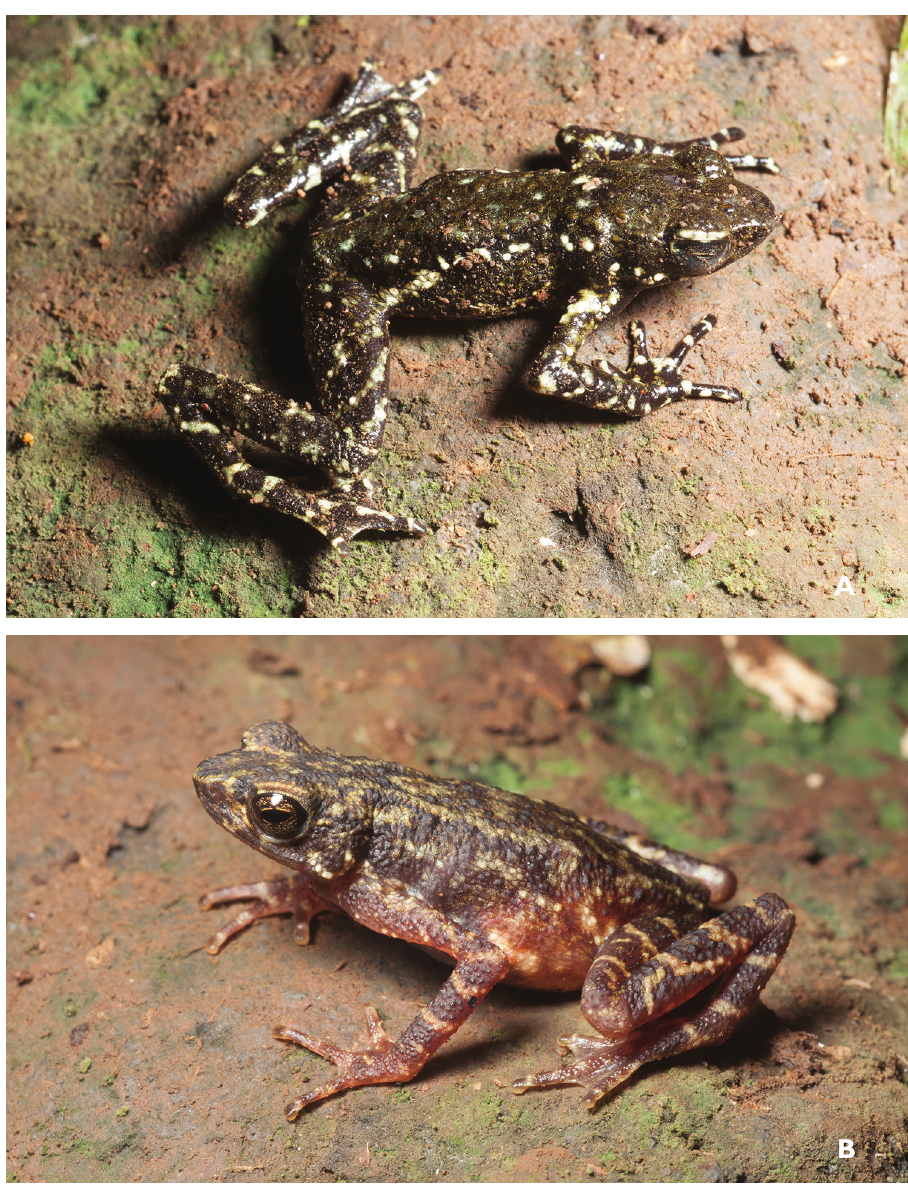
Figure 2. Ansonia muelleri male ( A KU 332971) and female ( B KU 334106) from Mt. Lumot, Municipality of Gingoog City, Misamis Oriental Province. Photos: